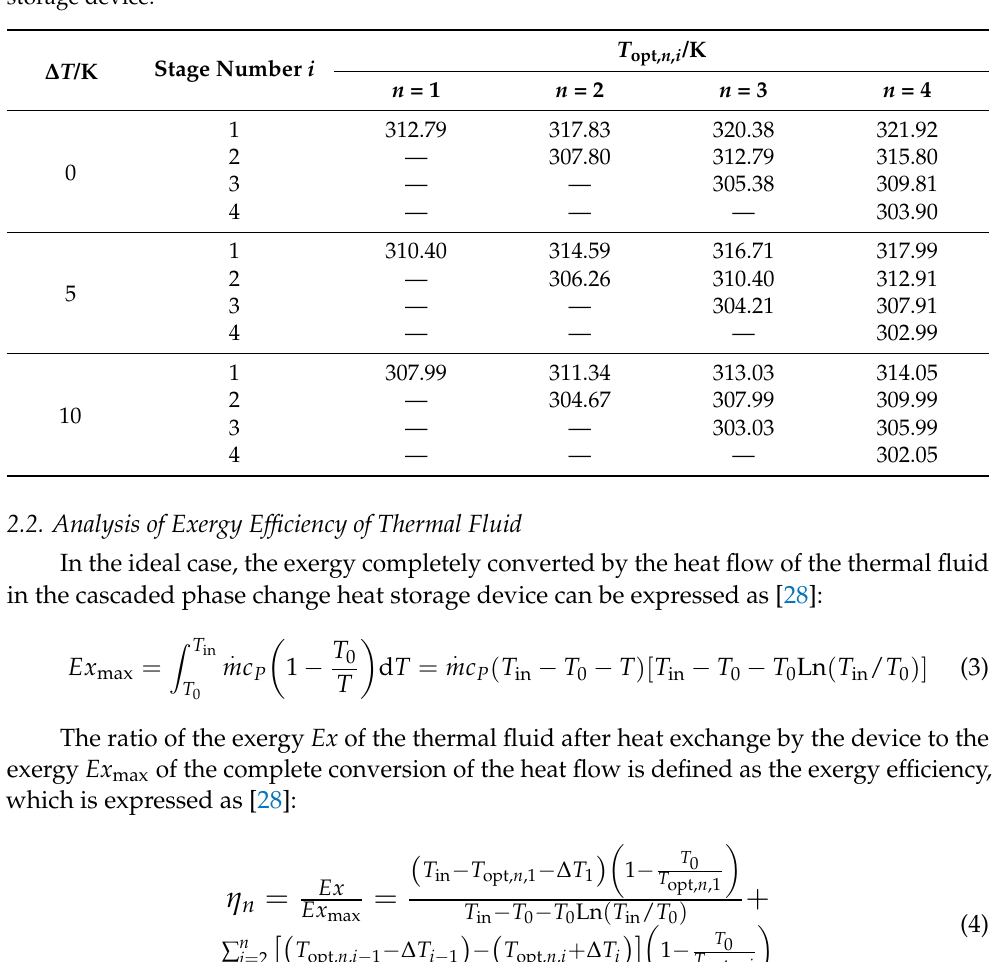
Table 1. Optimum phase change temperature in each stage of the cascaded phase change heat storage